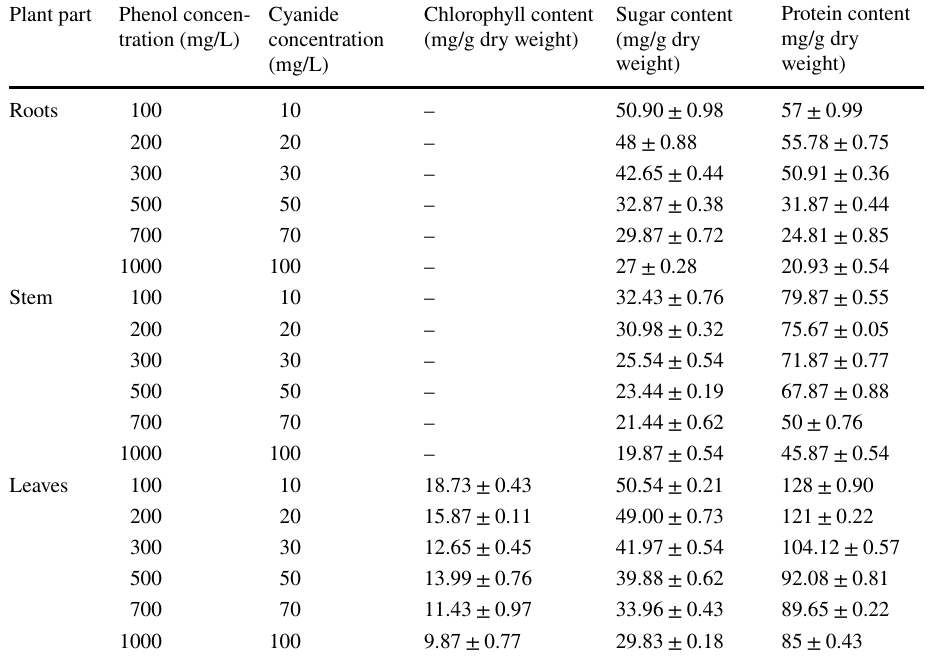
Plant part Phenol concen- tration